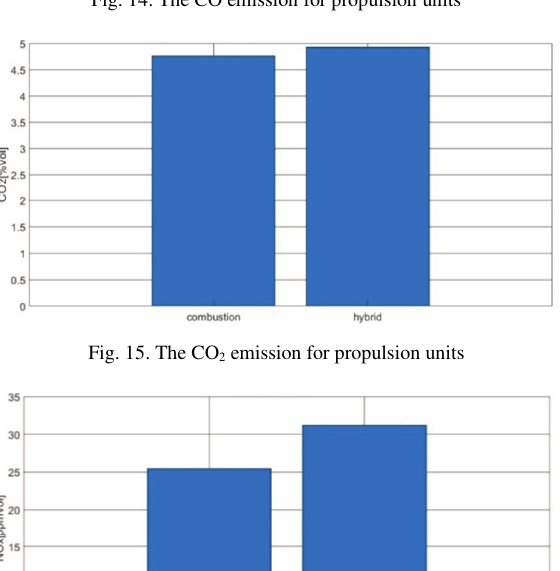
Fig. 14. The CO emission for propulsion units